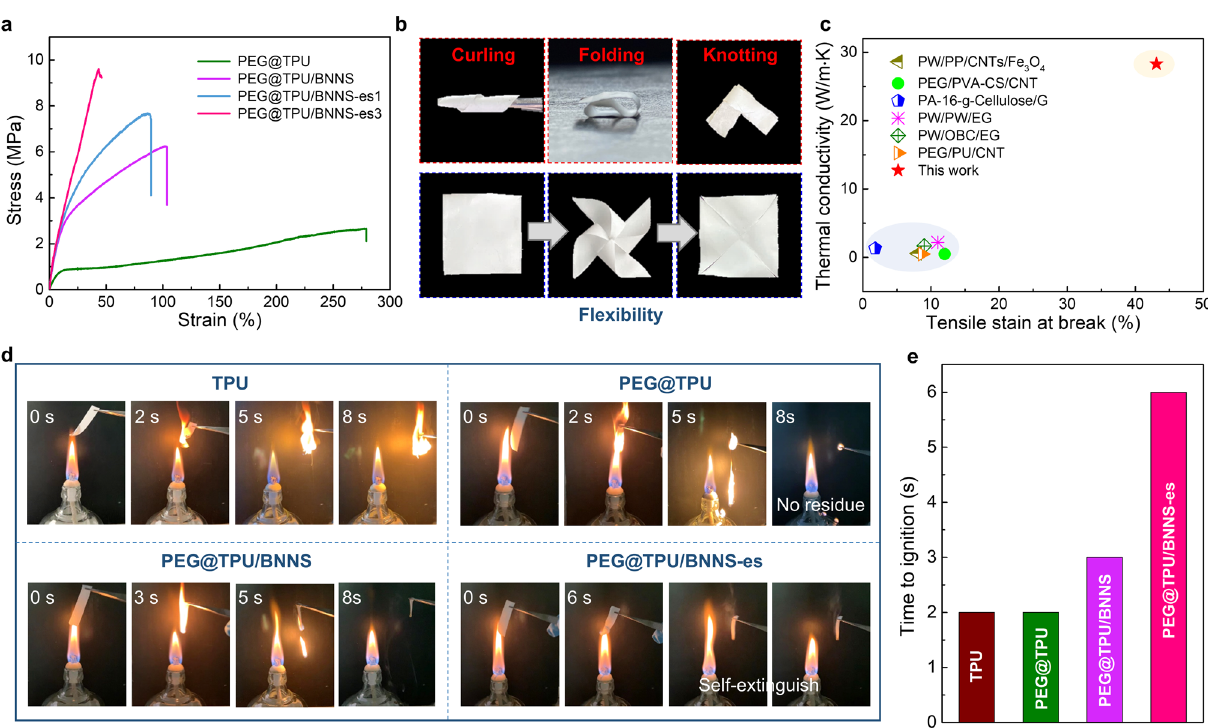
Fig. 4 Mechanical and fire-retardant properties of various materials. a Stress–strain curves of the core–sheath PCCs with different BNNS load- ing. b Optical photographs of the PEG@TPU/BNNS-es film under curling, folding and knotting conditions (top), and before and after shape recovery (bottom). c Thermal conductivity versus elongation at break of PEG@TPU/BNNS-es films and previously reported flexible PCNs [31, 33, 41, 47, 49, 50]. d Optical photographs showing the burning of various material by an alcohol lamp. e Ignition delay time of TPU and differ- ent